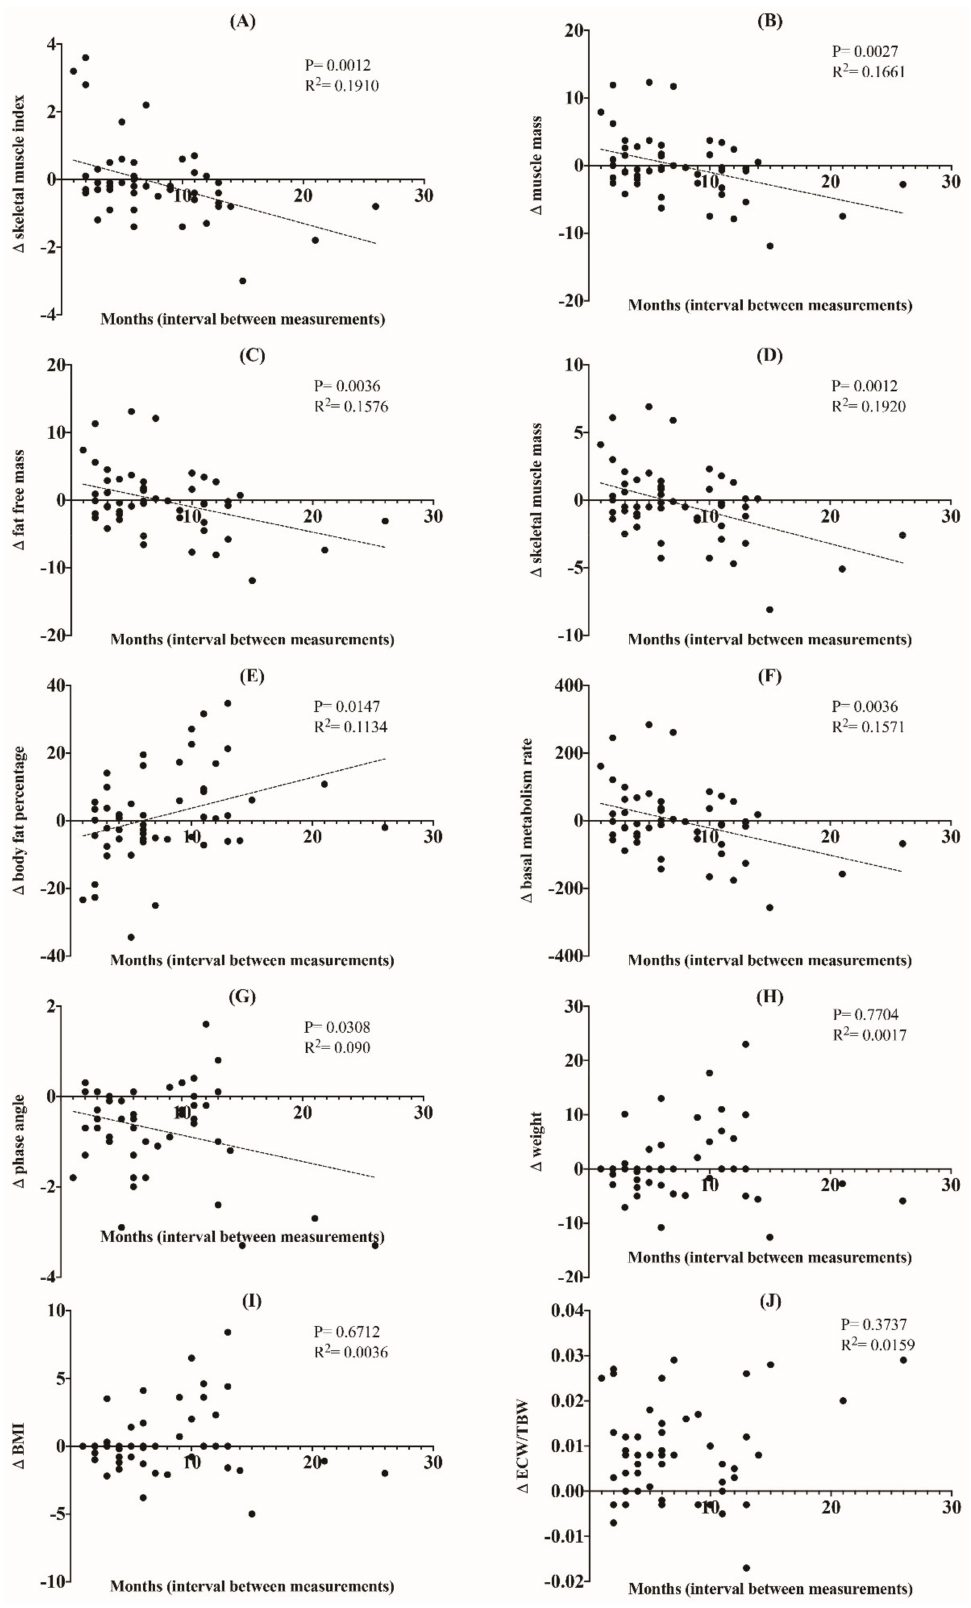
Figure 2. Linear regression showing changes in BIA parameters (skeletal muscle index ( A ), muscle mass ( B ), fat-free mass ( C ), skeletal muscle mass ( D ), body fat percentage ( E ), basal metabolism rate ( F ), phase angle ( G ), weight ( H ), BMI ( I ), ECW/TBW ( J )) versus interval (months) between BIA